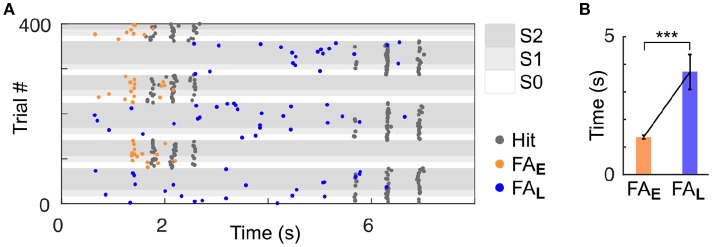
Mice were sensitive to temporal bias as revealed by their false alarm timing. (A) Example session of a mouse (ID 3). Each dot represents a response (Hit or FA). FA are color-coded based on the block type (Early or Late). (B) Significant increase in the median of FA time (measured from trial onset) in the Late vs. Early condition. Error bars represent median absolute deviation. ***P < 0.001.